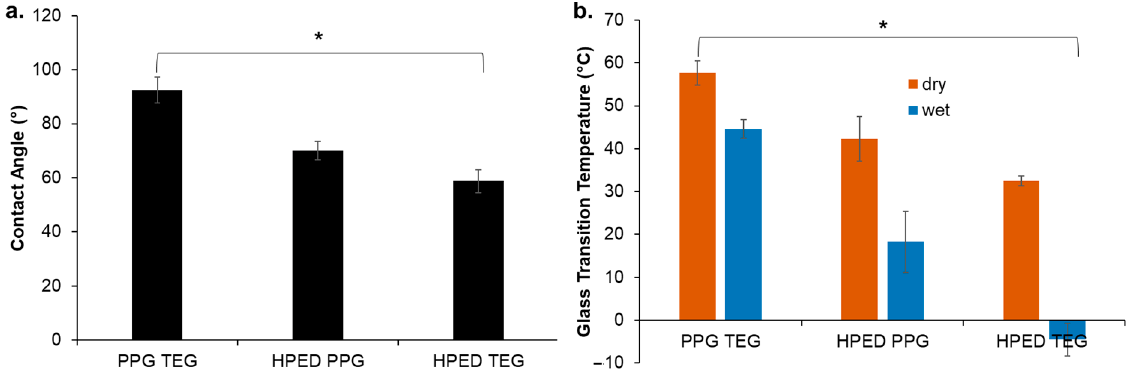
Figure 2. ( a ) Contact angle and ( b ) glass transition temperature in dry and wet conditions. Mean ± standard deviation displayed. n = 3. * p < 0.05 between all formulations and measurement conditions.